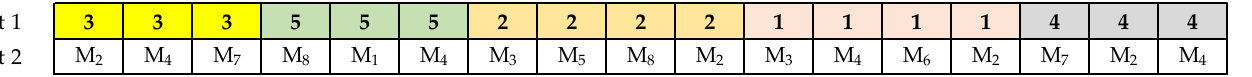
Figure 11. Solution example with the heuristic EDD.